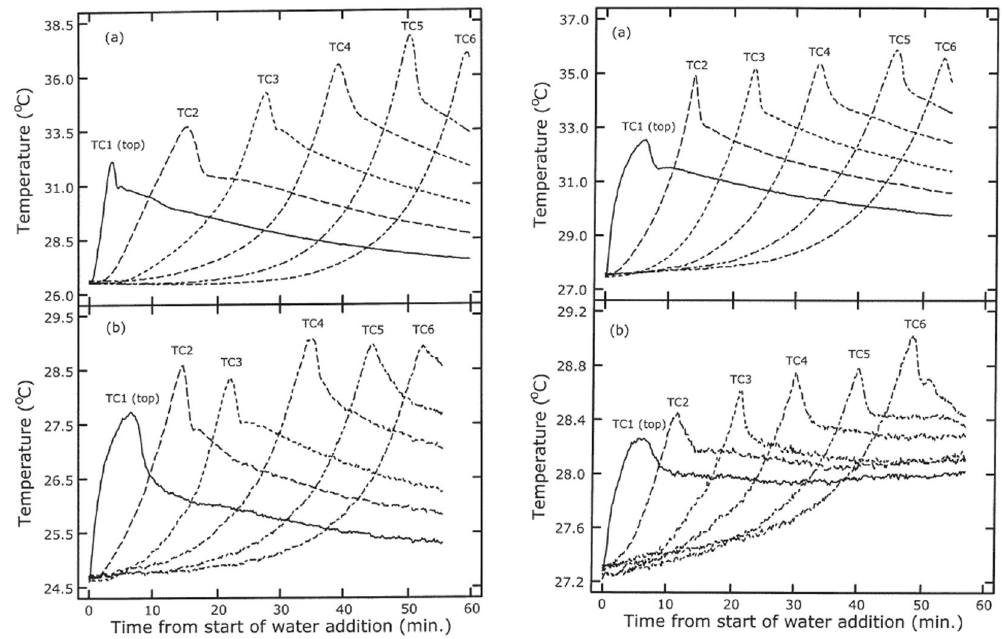
Figure 10. Temperature as a function of time measured at different locations in experiments of Prunty and Bell 10 . The two plots on the left are from columns containing silty clay soil ( a ) dry and ( b ) with 0.04 g/g. Plots on the right are for loamy